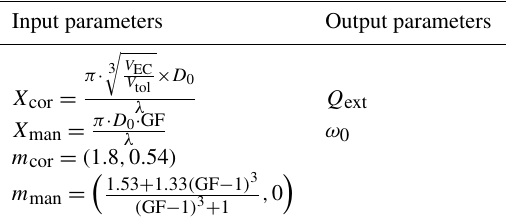
Table 2. Input/output parameters of the efficiency factor ( Q ext ). ω 0 is the single scattering albedo.